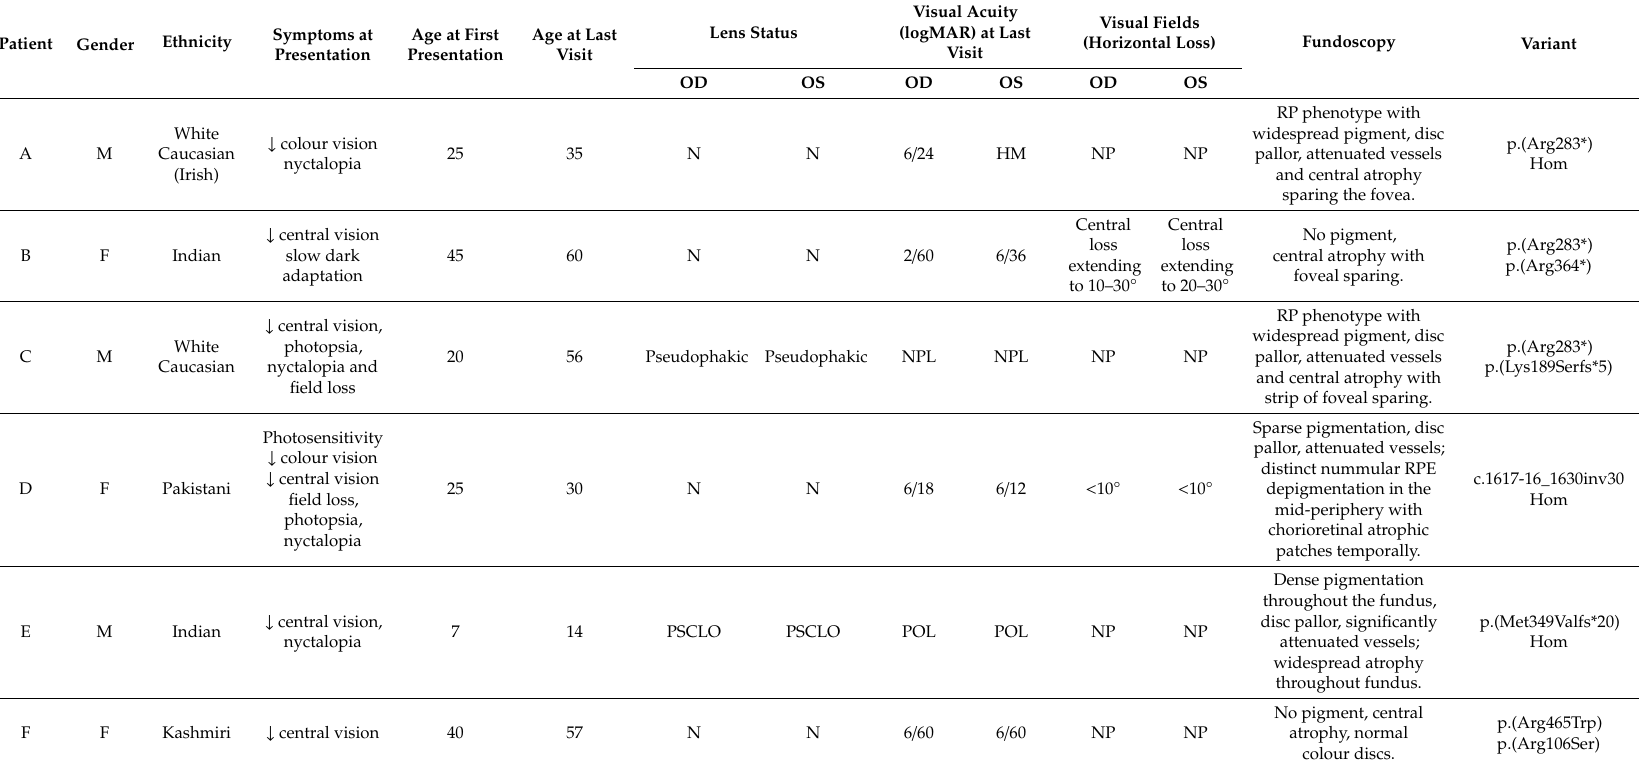
Table 2. Clinical